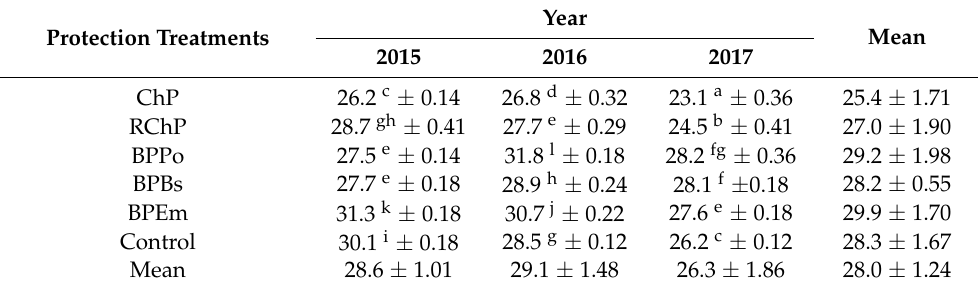
Table 7. Effect of protection treatments and year of horseradish cultivation on dry matter con- tent [g · 100 g − 1